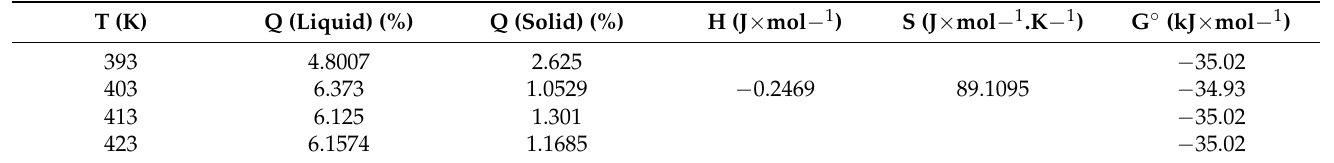
Table 7. Thermodynamic parameters of the extraction